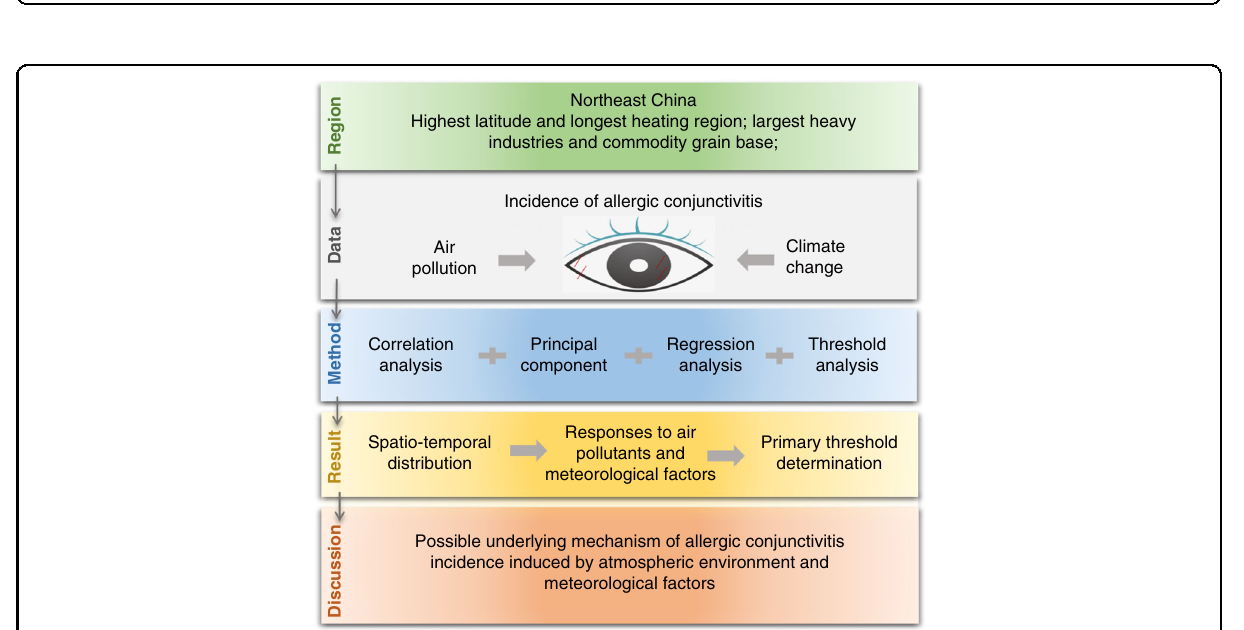
Fig. 7 Topography, administrative division, and cities with data sources in the three provinces of Northeast China. Tagged cities represent the valid data of both air pollution and allergic conjunctivitis